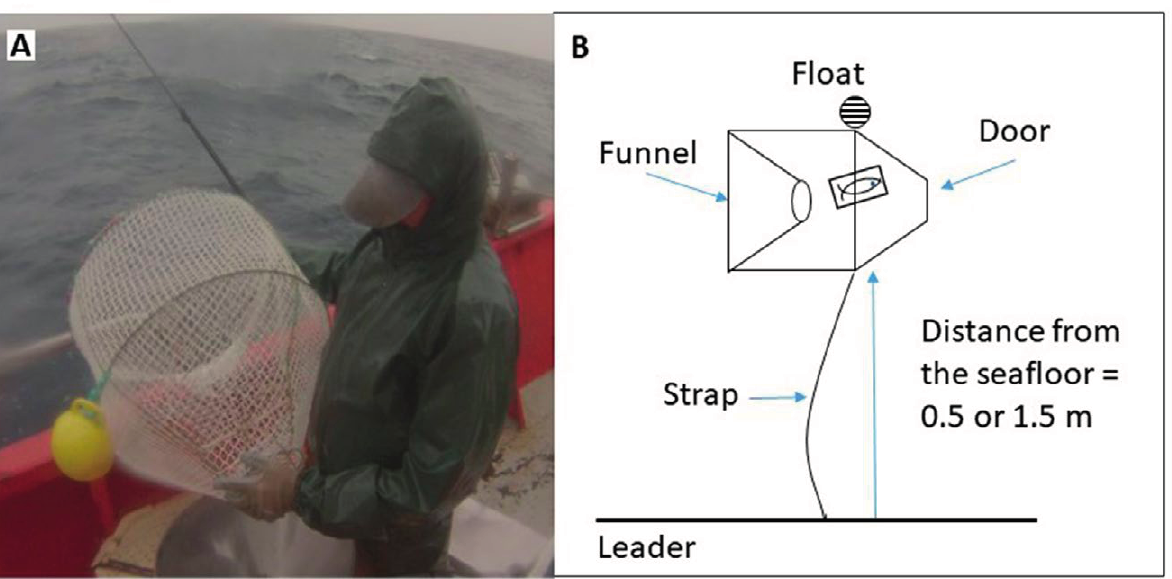
Fig. 1. – Semi-floating shrimp traps used in the experiment. A, photo of a trap; B, scheme of the trap and attachment to the main line.